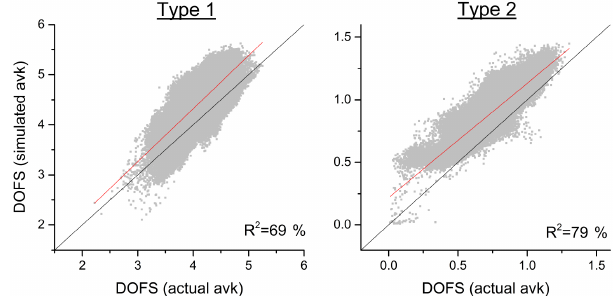
Figure 5. Comparison of the DOFS values obtained from the actual and the simulated averaging kernels. Left for the Type 1 product and right for the Type 2